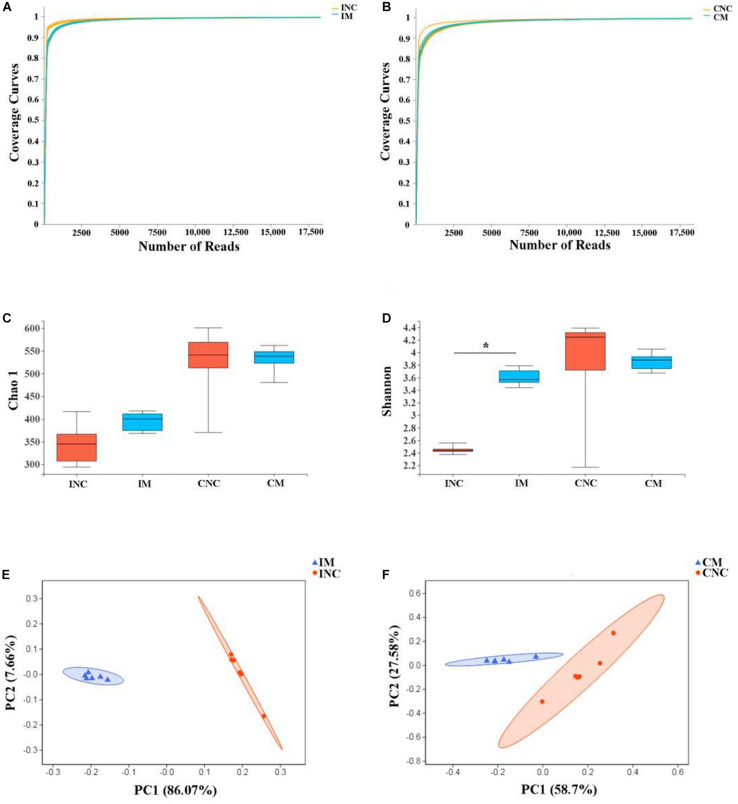
Alpha diversity and PCoA of bacterial communities between control and montmorillonite treatments in ileum and colon from weaned piglets. Sequencing coverage curves of negative control (INC) and (A) basal diet with 0.2% montmorillonite (IS) from the ileum and negative control (CNC) and (B) basal diet with 0.2% montmorillonite (CS) from the colon. (C) Chao 1 index of bacterial community and (D) Shannon index of bacterial community in four groups. The PCoA analyses of bacterial communities between control and montmorillonite treatment group from (E) ileum and (F) colon. The results were analyzed by Wilcoxon rank-sum test and *P < 0.05.